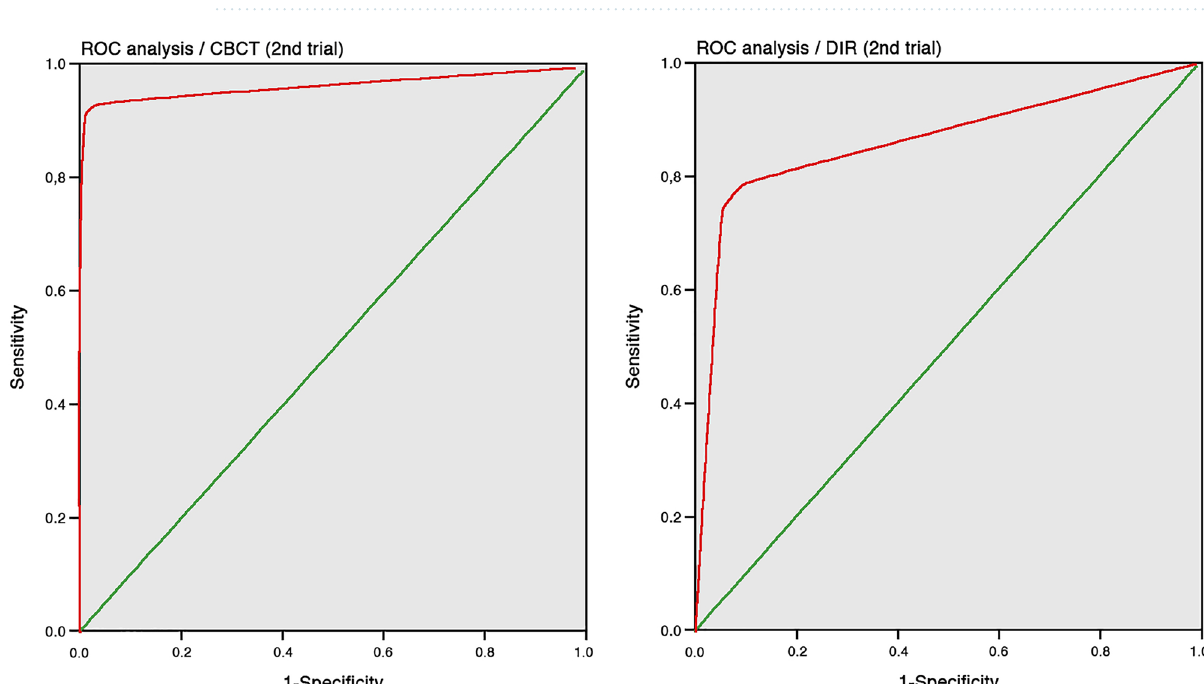
Figure 6. ROC analysis: CBCT (left) and DIR (right) of the second trial being the16 observers pooled with both image acquisition